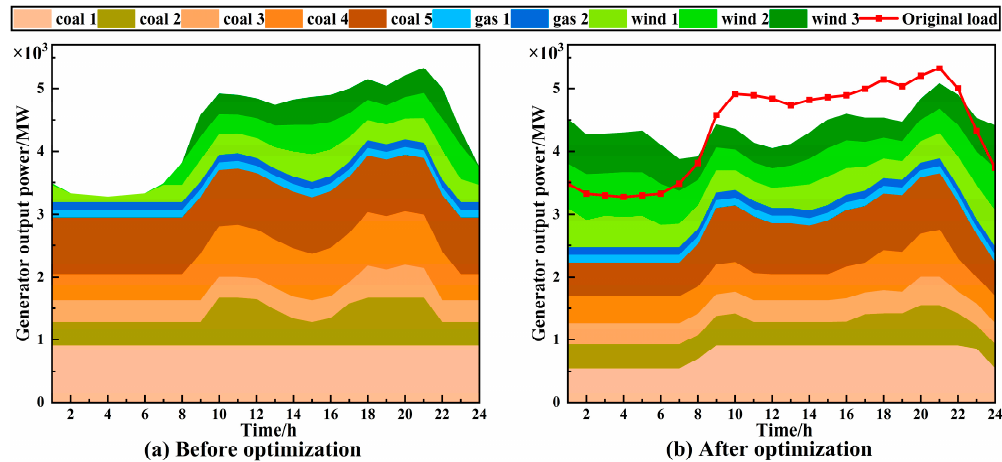
Figure 8. The output power of each generator before and after optimization.